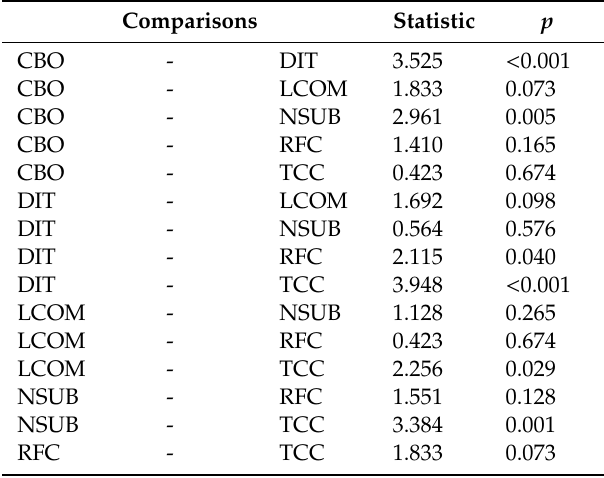
Table 10. Post-hoc pairwise comparison of importance ranks of software metric changes in contribution in predicting future MINC